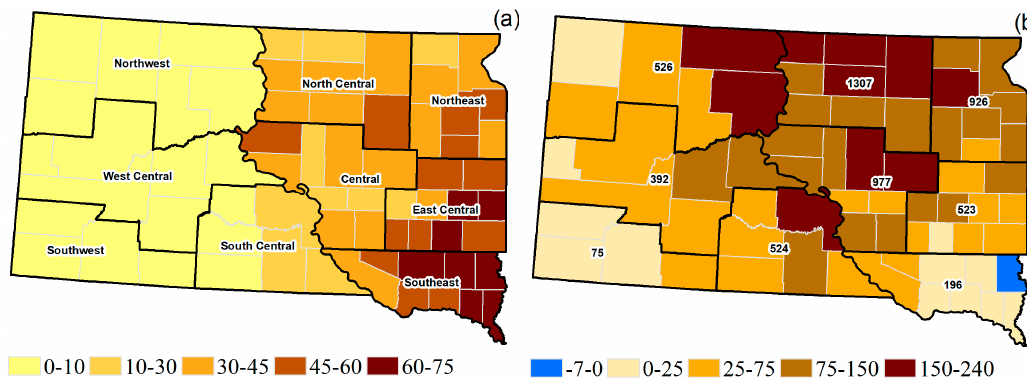
Figure 4. ( a ) County-level stable cropland coverage in %, and ( b ) cropland net expansion in km 2 . The maps were overlaid with NASS reporting districts. Numbers on ( b ) present net cropland gains summarized by NASS districts.